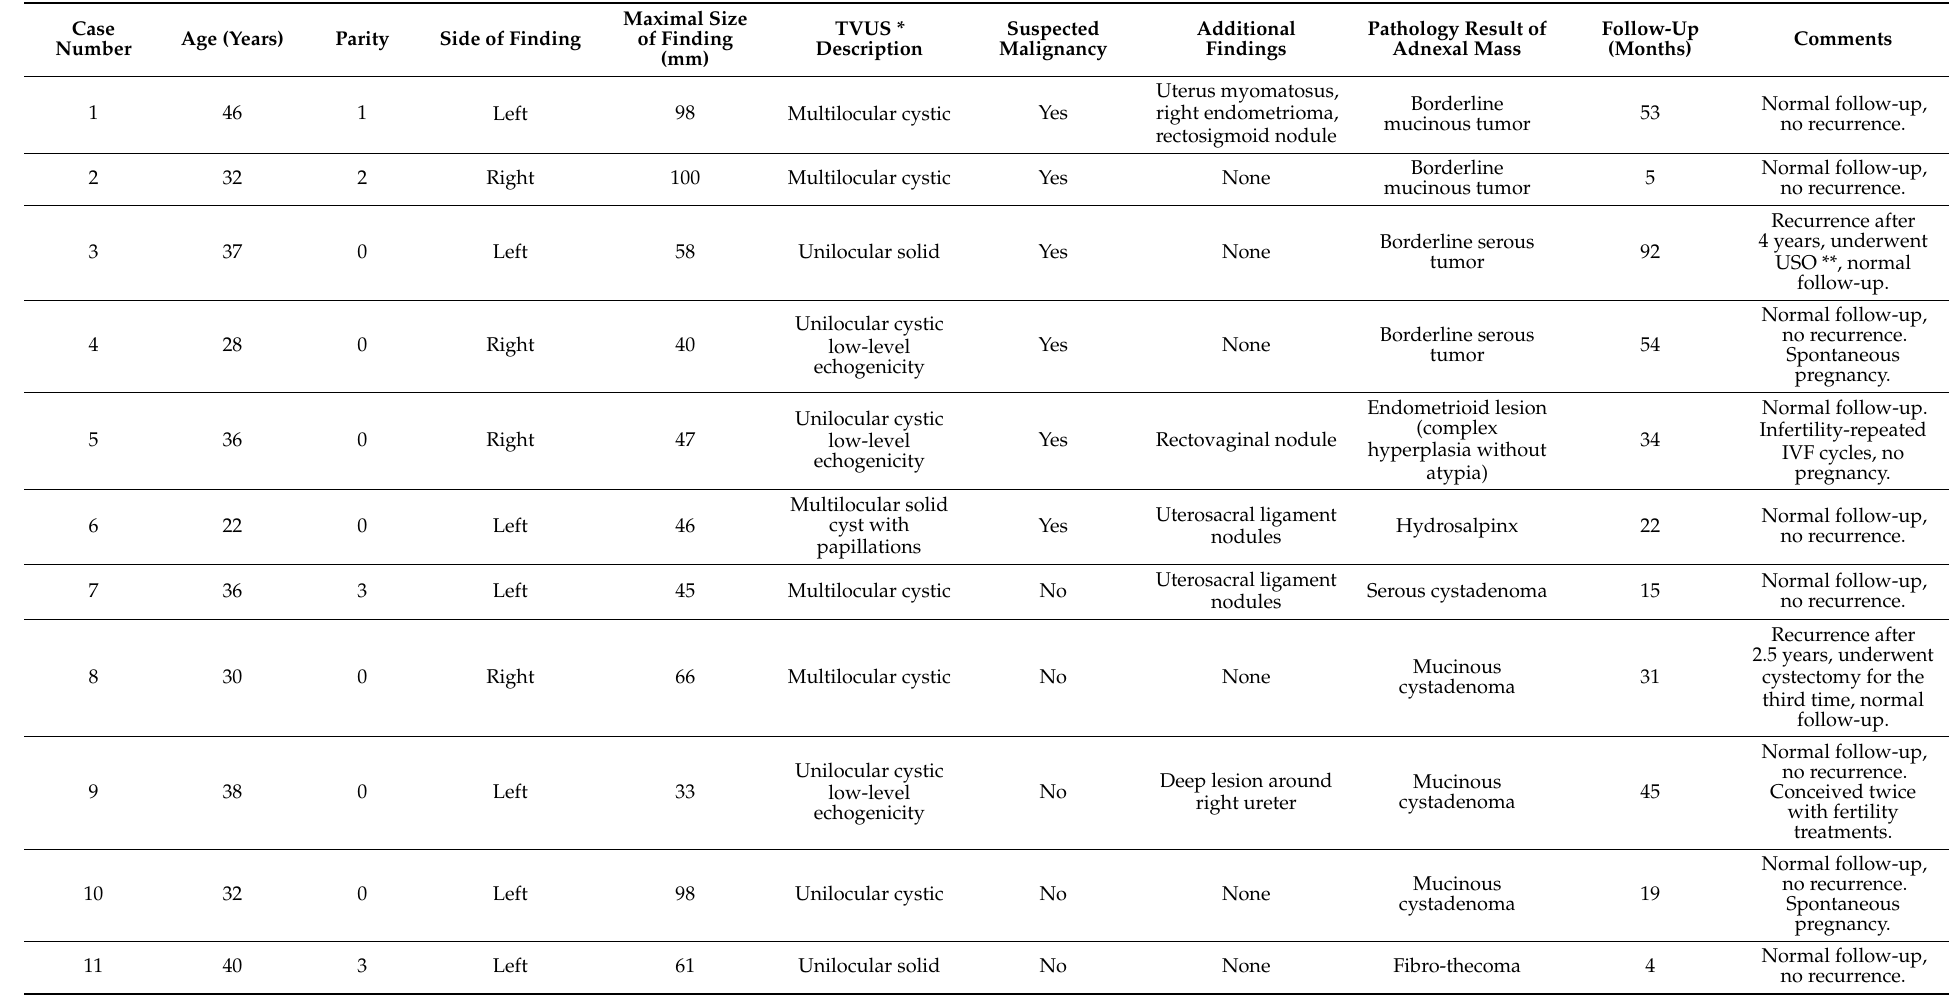
Table 2. Clinical data, findings on TVUS and surgery and pathology results of women with malignant adnexal masses and different benign adnexal